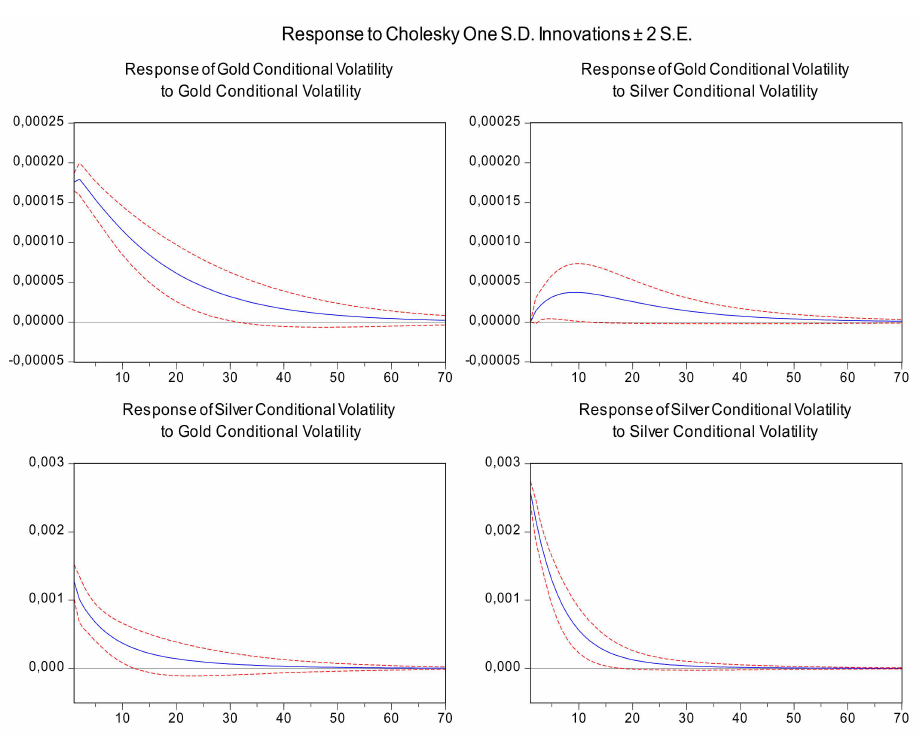
Figure 5. Monthly